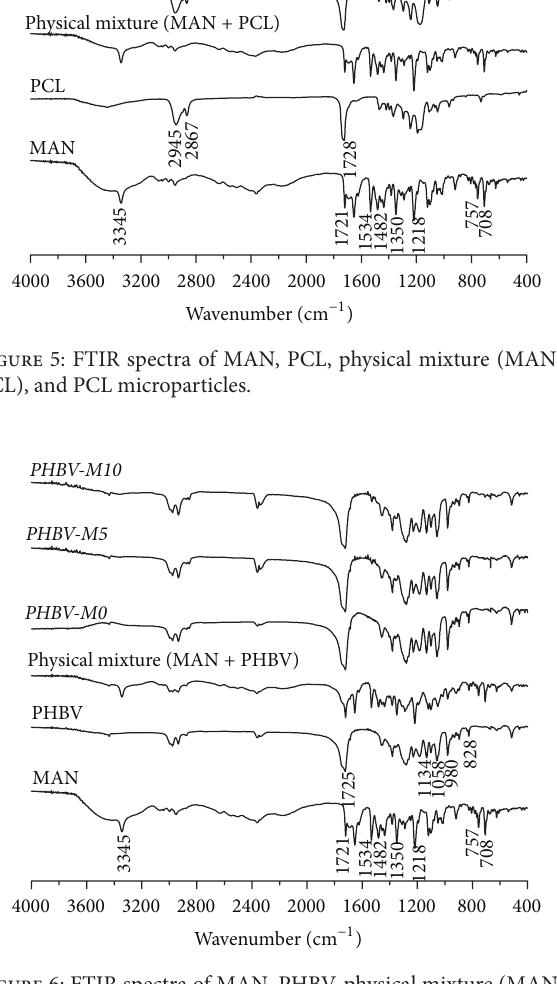
Figure 6: FTIR spectra of MAN, PHBV, physical mixture (MAN + PHBV), and PHBV microparticles.